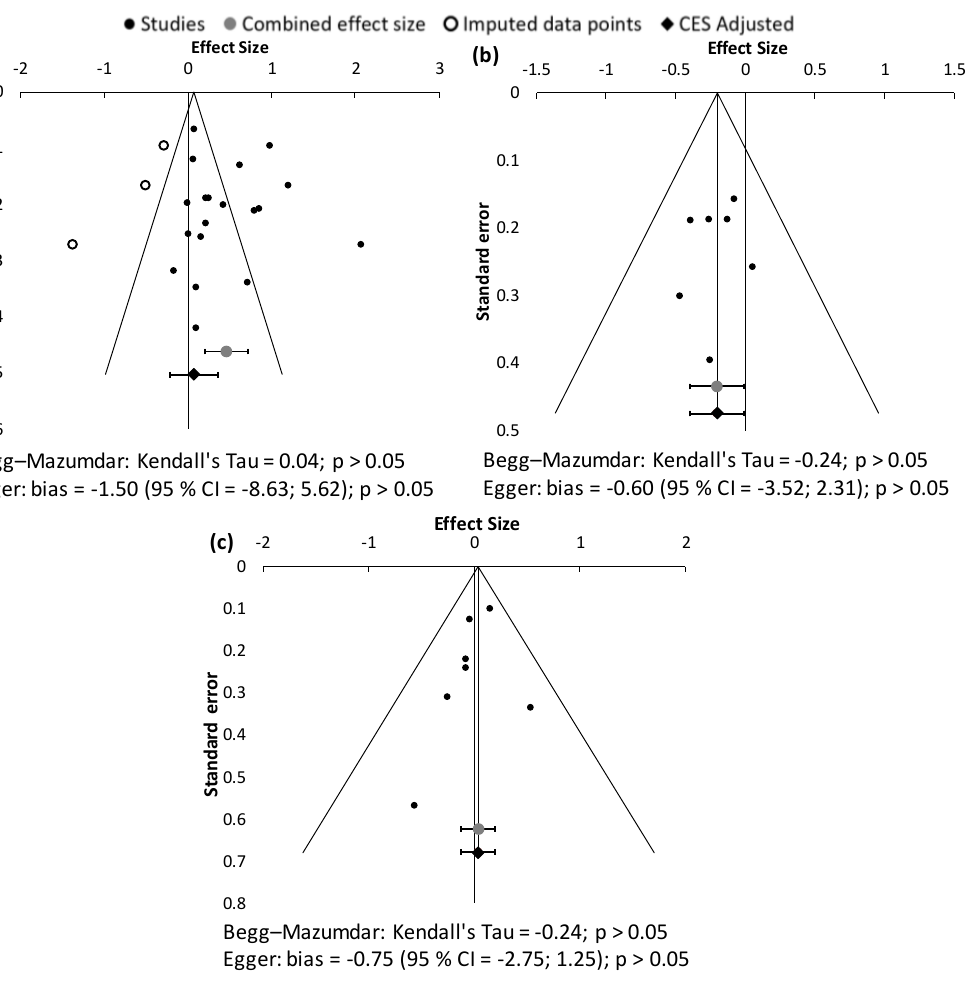
Figure 3. Funnel plots and asymmetry tests corresponding to the meta-analysis of the parameters eGFR ( a ), Cr pl ( b ), and albuminuria ( c ). The effect size is measured as Hedges’ g ± 95% CI. CES: combined effect size; CI: confidence interval.